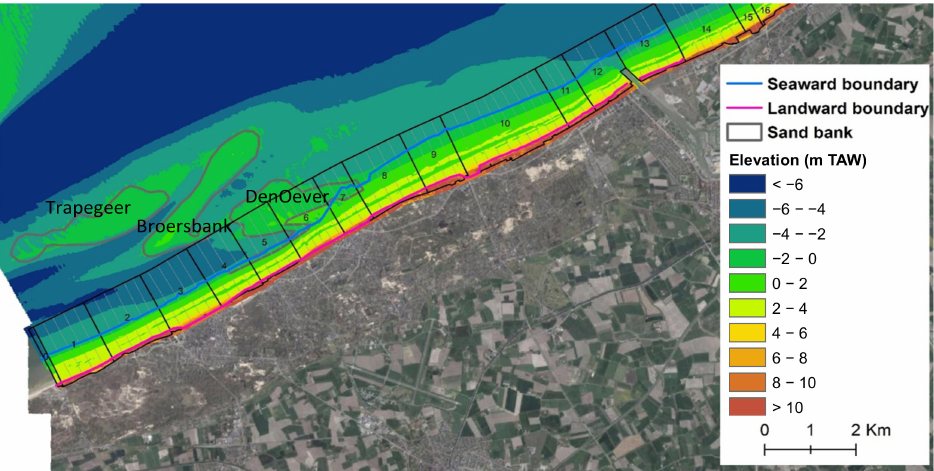
Figure 4. Delineation of the active zone in the study area (from stretches 1 to 13) based on profile